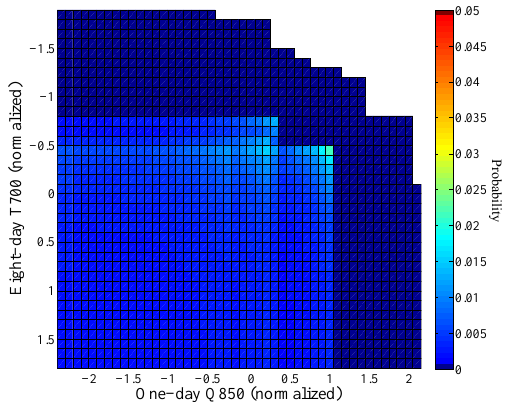
Figure 9. Probability of a flash event from summer synoptic rainfall based on 8-day mean temperature at 700hPa and 1-day normalized specific humidity at 850hPa between 1989 and 2003. The y axis is inverted to highlight that the figure represents the probability of a flash event given that T700 is less than the a particular value and Q850 is greater than a particular